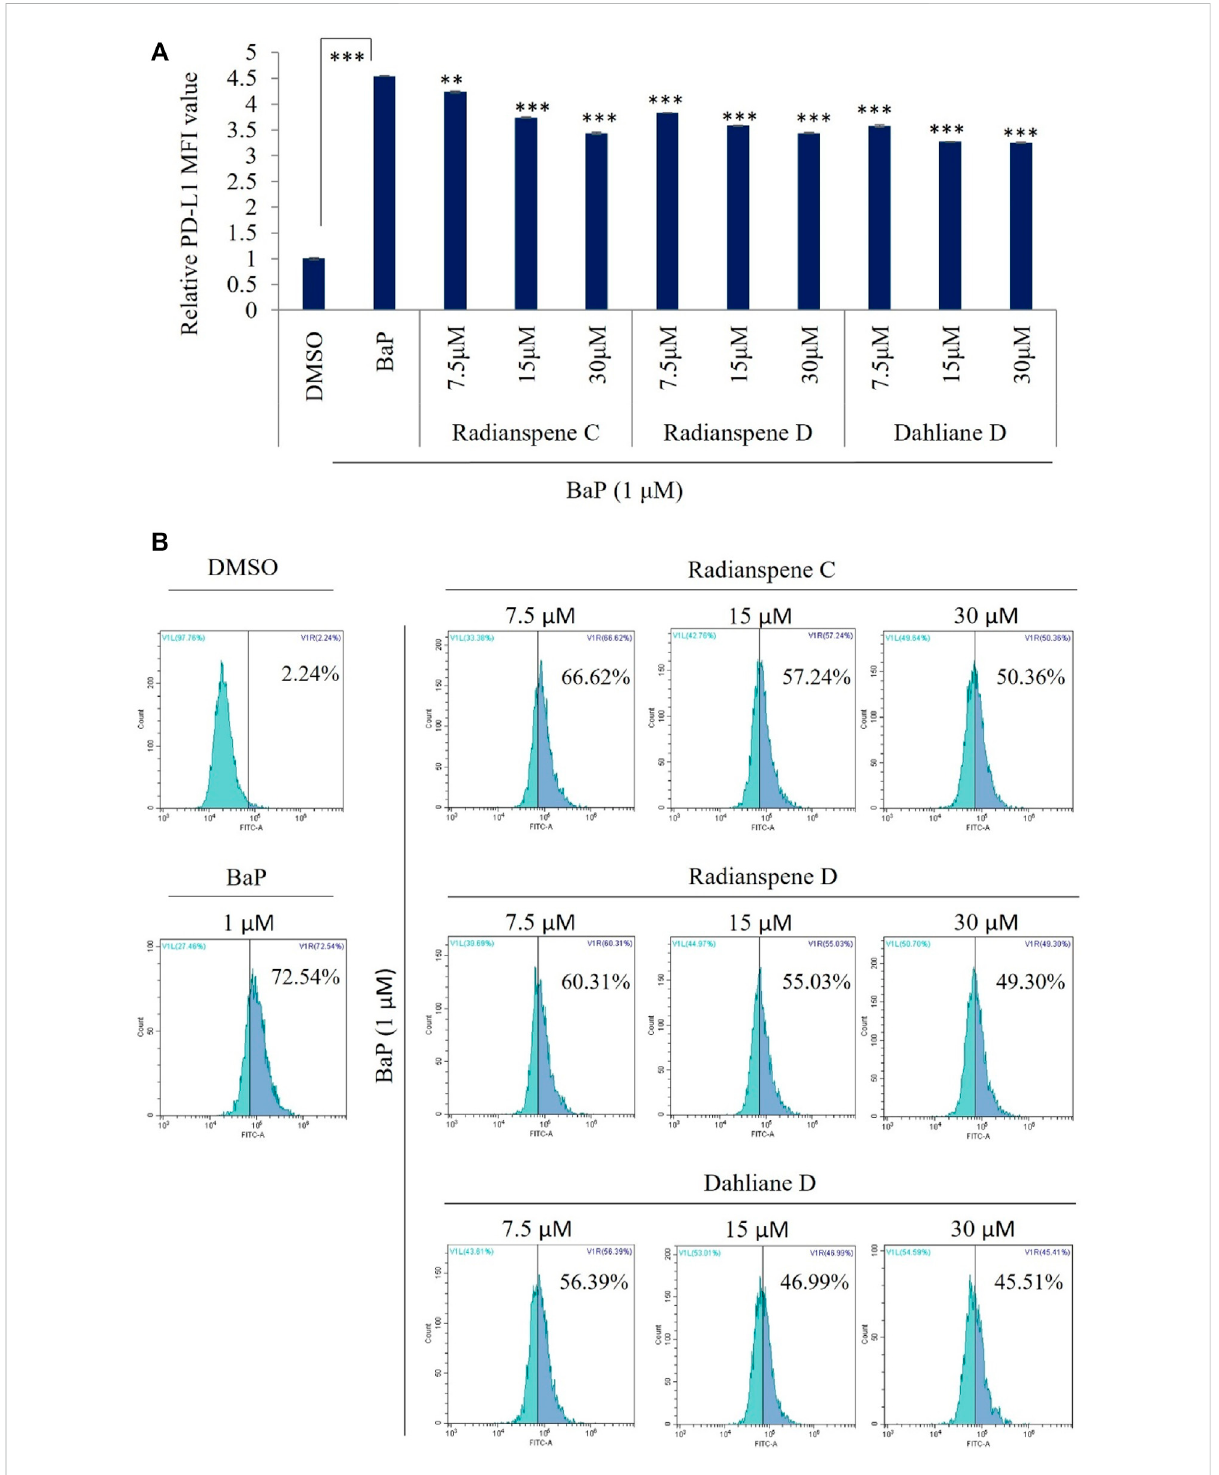
FIGURE 4 Evaluated the the PD-L1 surface protein activity on benzo[a]pyrene induction condition, treated with radianspenes C and D, and dahliane D. H1975 cells were treated with radianspenes C and, D and dahliane D, at 7.5, 15, and 30 µM ( (cid:1) 2.5, 5, 10 µg/mL) 4 h prior to exposure benzo[a]pyrene (1 µM) and then cells were incubated for 72 h, and PD-L1 surface protein level was measured using fl ow cytometry. Relative PD-L1 MFI value was determined by fl ow cytometry (A,B) . MFI: mean fl uorescence intensity. * p < 0.05; ** p < 0.01; *** p < 0.001; NS, no signi fi cant difference when compared with the BaP-treated group or between indicated